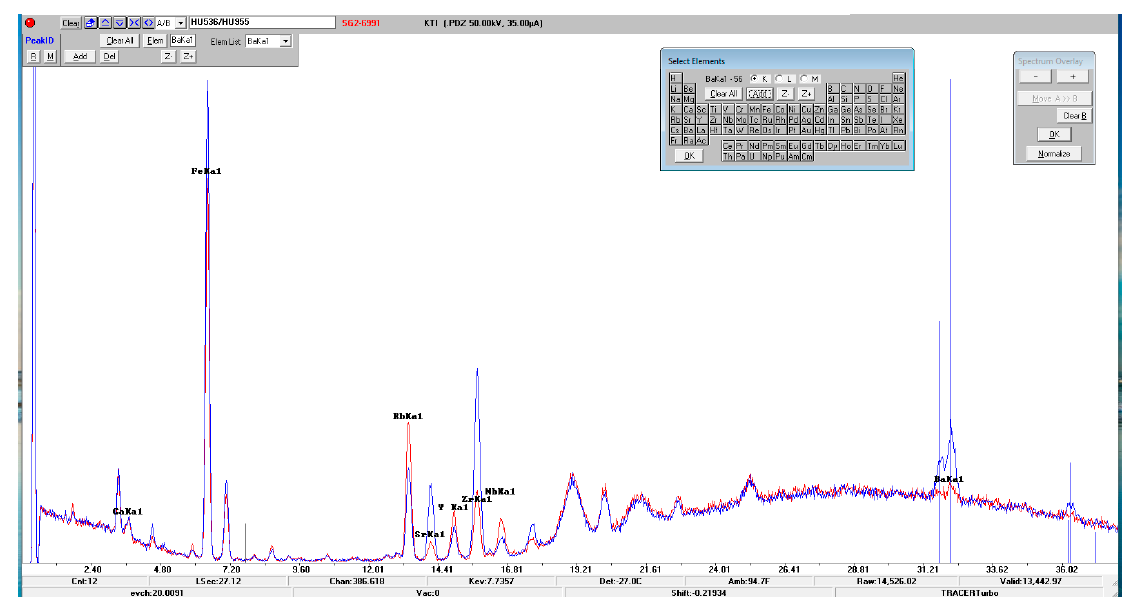
Figure 4. K-line energy peaks for two obsidian samples. In blue is from Monte Arci (Sardinia) SC; note the high strontium, zirconium, and barium peaks when compared to SA (in red). The blue lines represent the multiple peaks for barium.